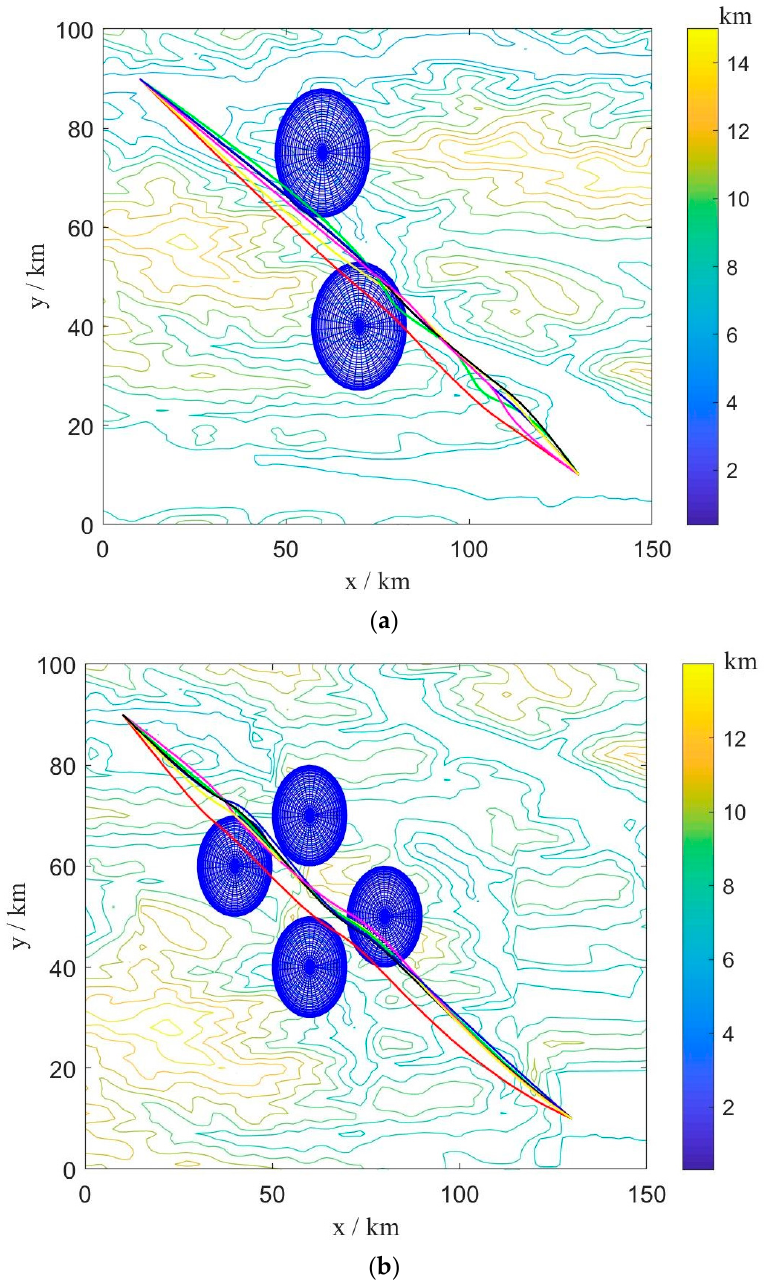
Figure 8. Path planning results of BINN-HHO on a 2D simulation map. ( a ) Static case I. ( b ) Static case II.